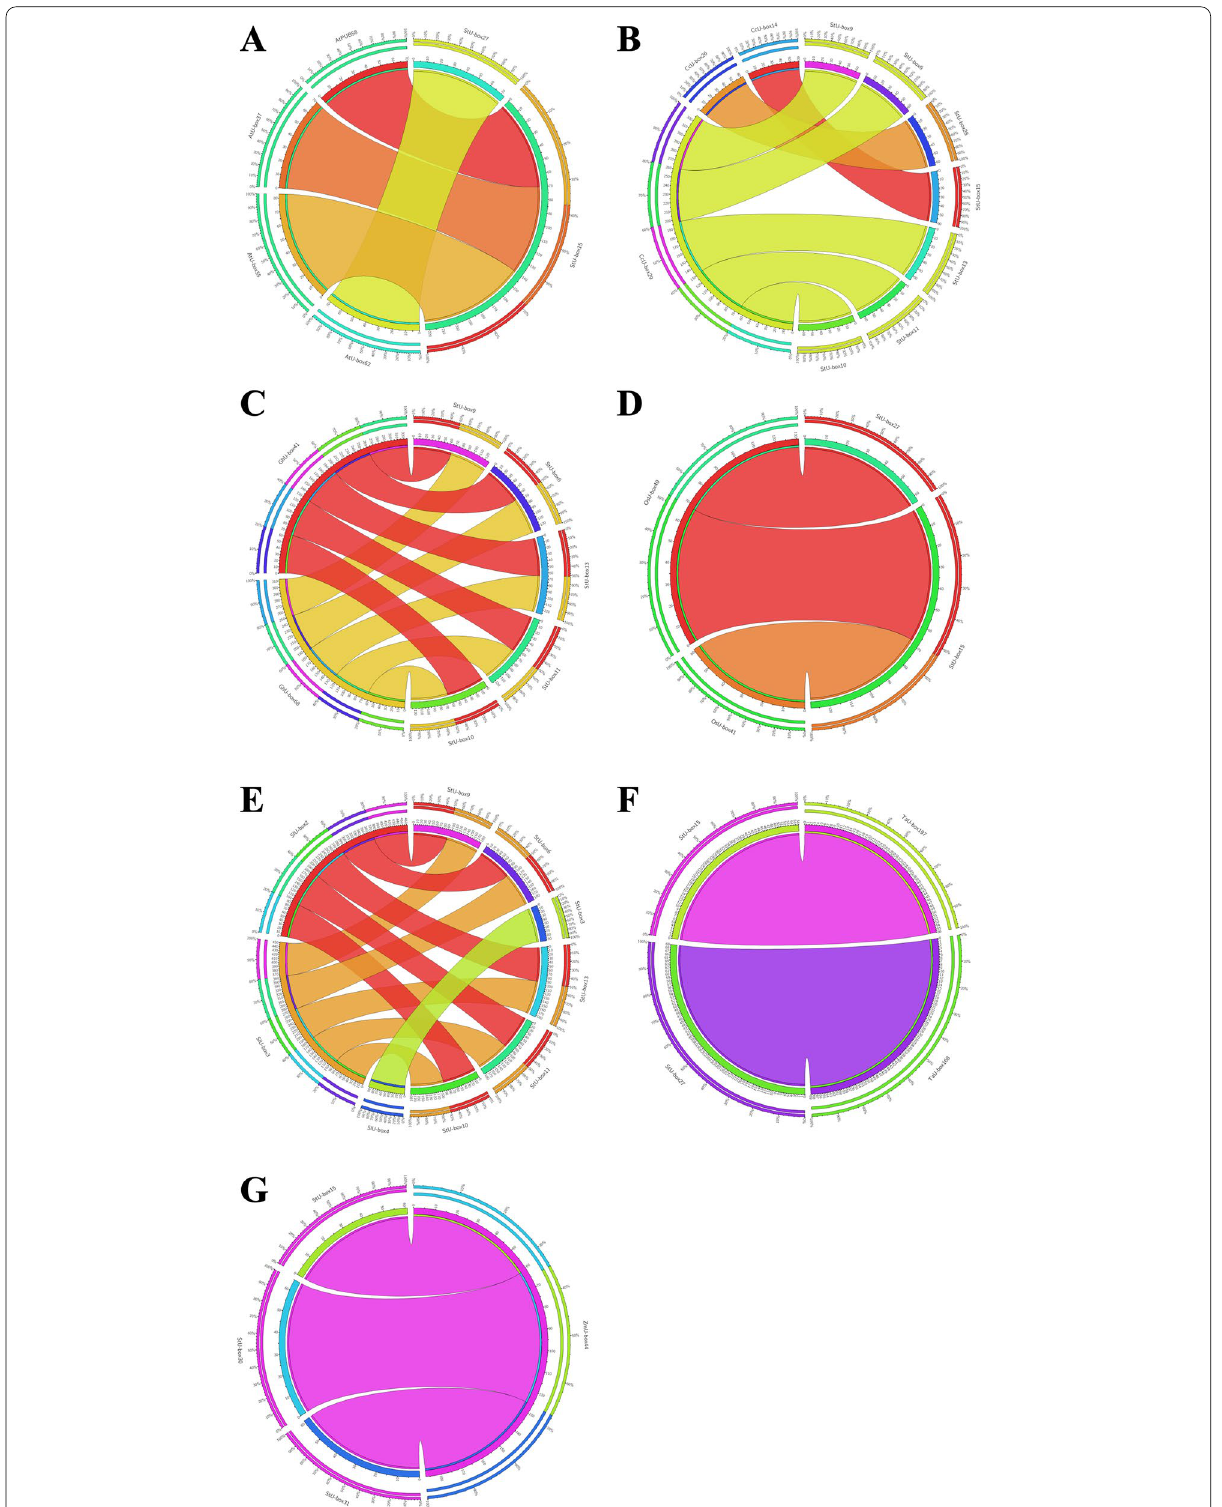
Fig. 6 Synteny analysis of potato U-box genes with A A . thaliana , B C . mytifolia , C G . hirsutum , D O . sativa , E S.lycopersicum , F T . aestivum , and G Z . maize as visualized by online